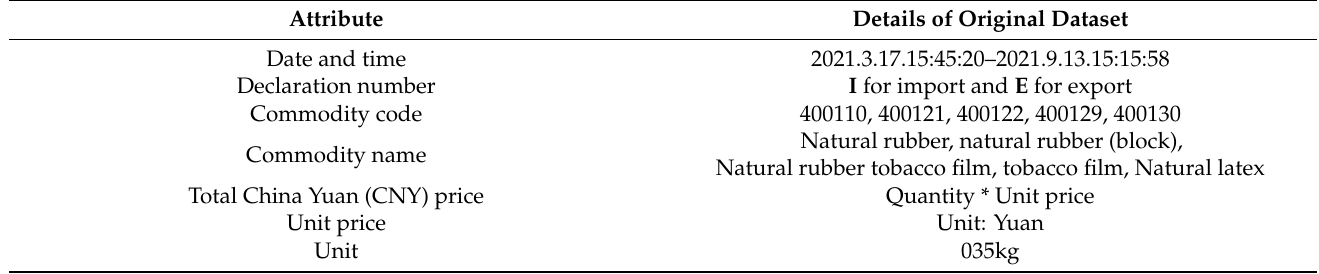
Table 1. The various attributes and details of original NRCDP dataset.